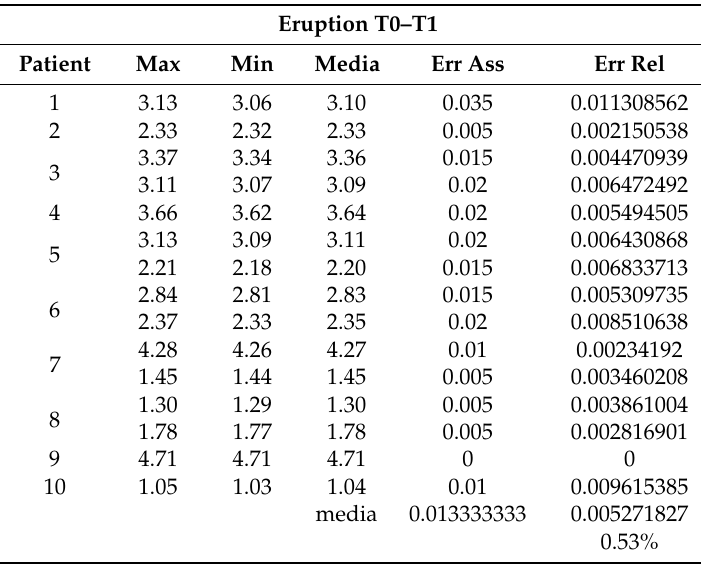
Table 9. Observational Error to two months (T0–T1).